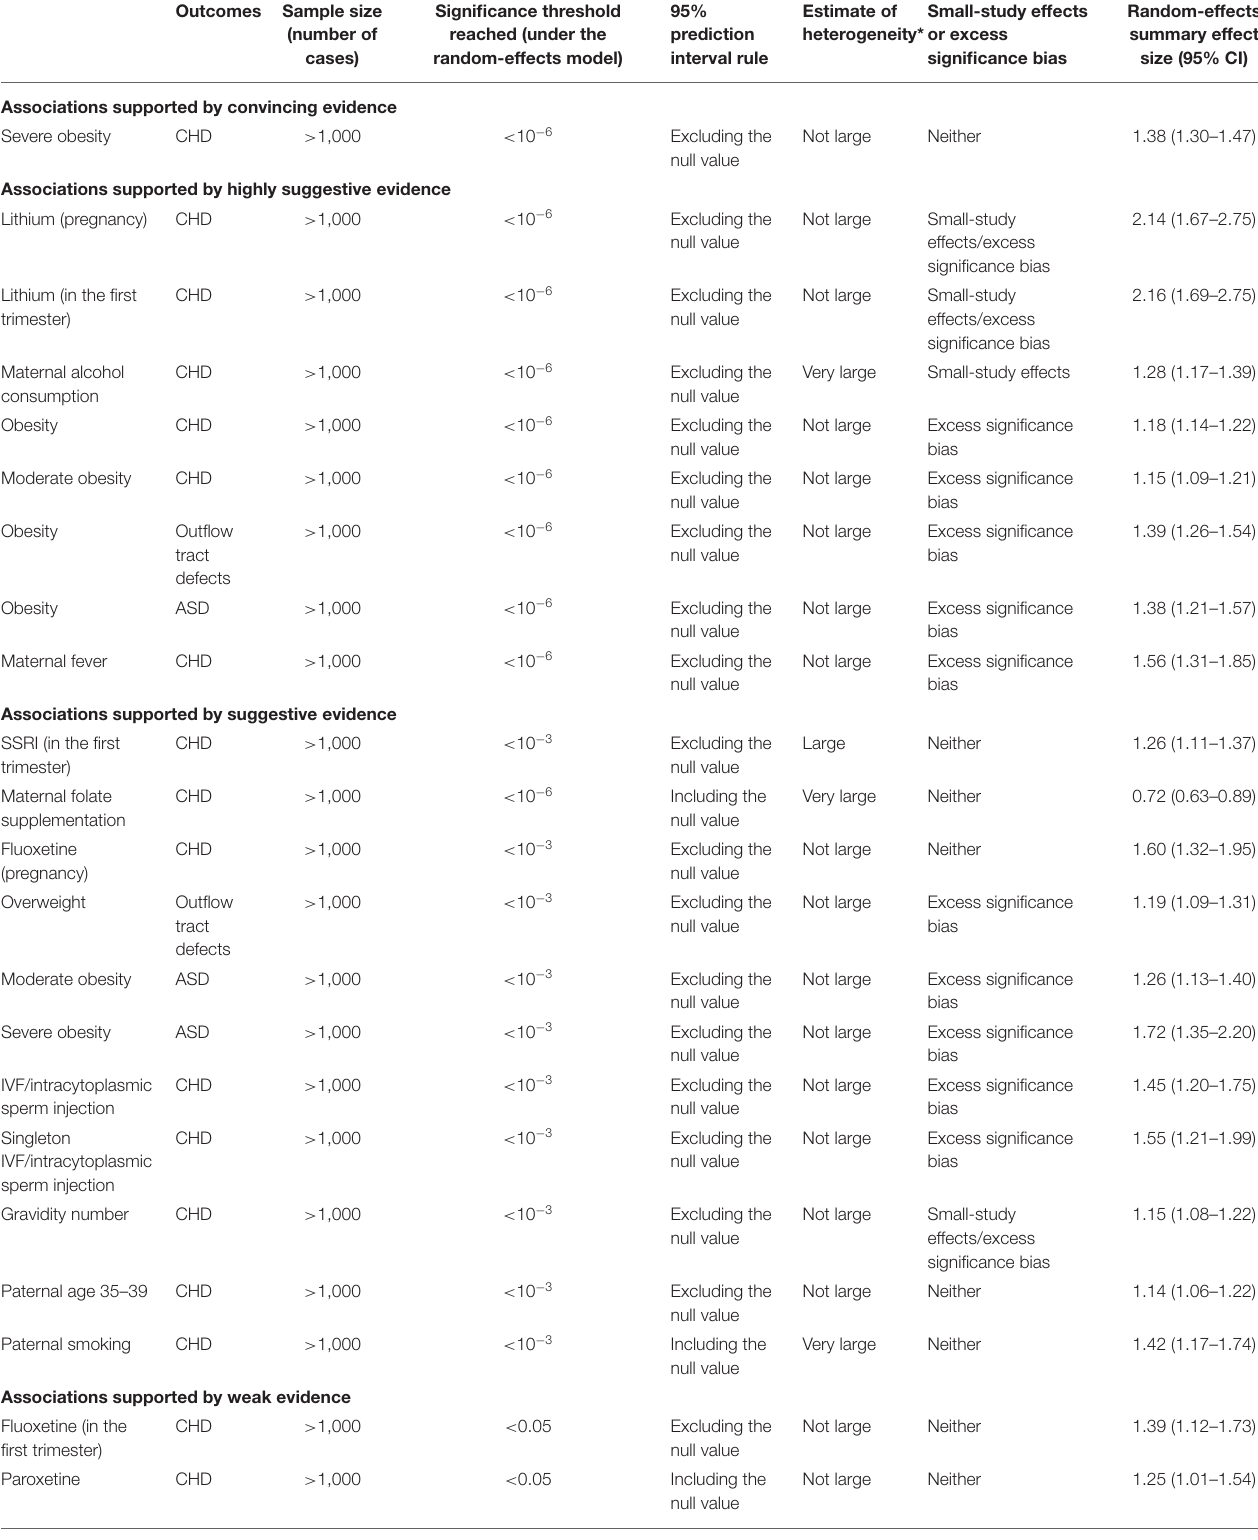
TABLE 1 | Assessment across the 63 associations of environmental risk factors with CHD. Outcomes Sample size Significance threshold (number of reached (under the cases) random-effects model)